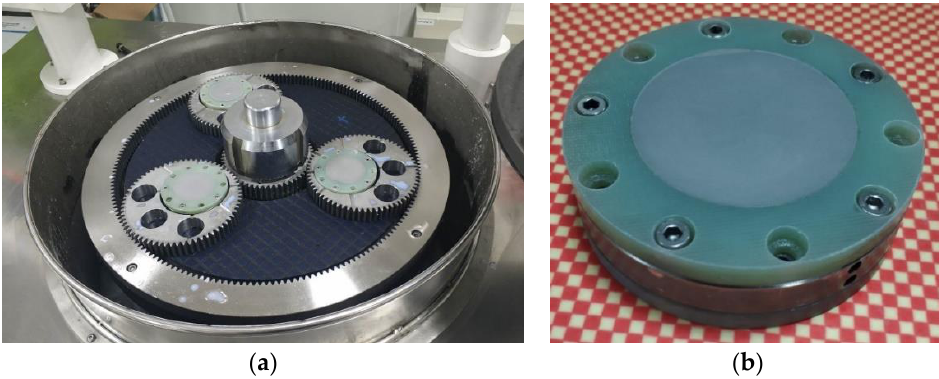
( b ) Figure 6. Influence of different materials on adhesion and van der Waals force: ( a ) comparison of experimental and theoretical values of adhesion force under different materials; ( b ) variation of van der Waals’ theoretical value under different materials. 5. Double-sides Polishing Experiment Based on LSC According to the analysis, more than 1.4 N of normal adhesion force can be generated between